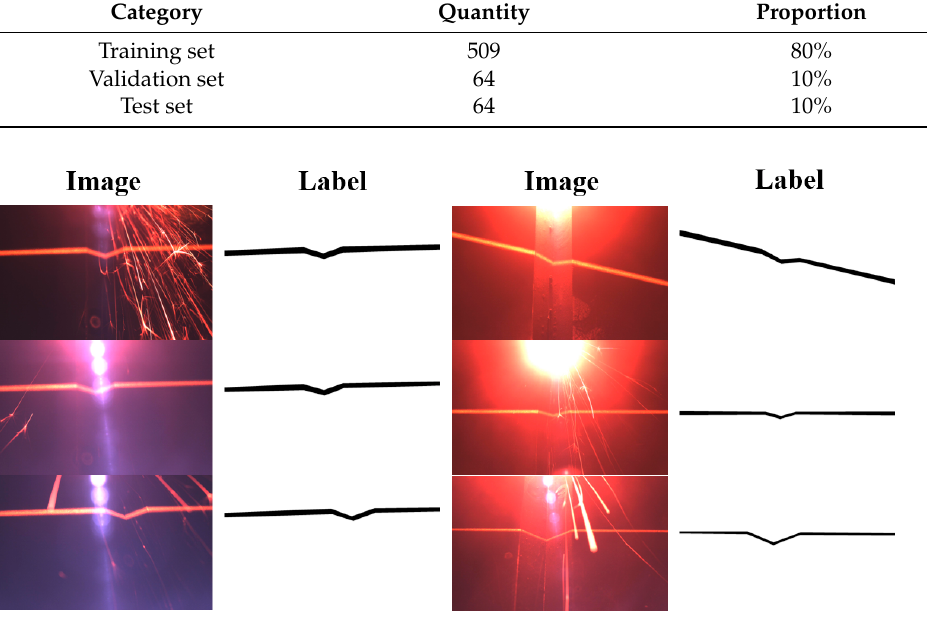
Figure 4. Part of the original and labeled images.